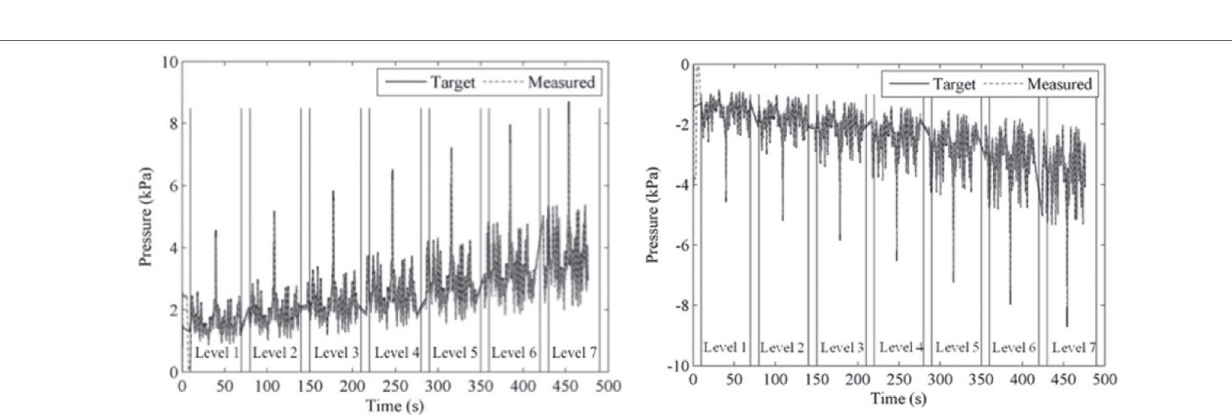
FigUre 4 | Time histories of target and measured wind pressure at seven intensity levels for two load conditions (2 hz positive and negative cutoff, respectively) . The target pressure represents the pressure that is desired to replicate using the pressure simulator, and the measured pressure represents the actual pressure achieved in the pressure chamber.